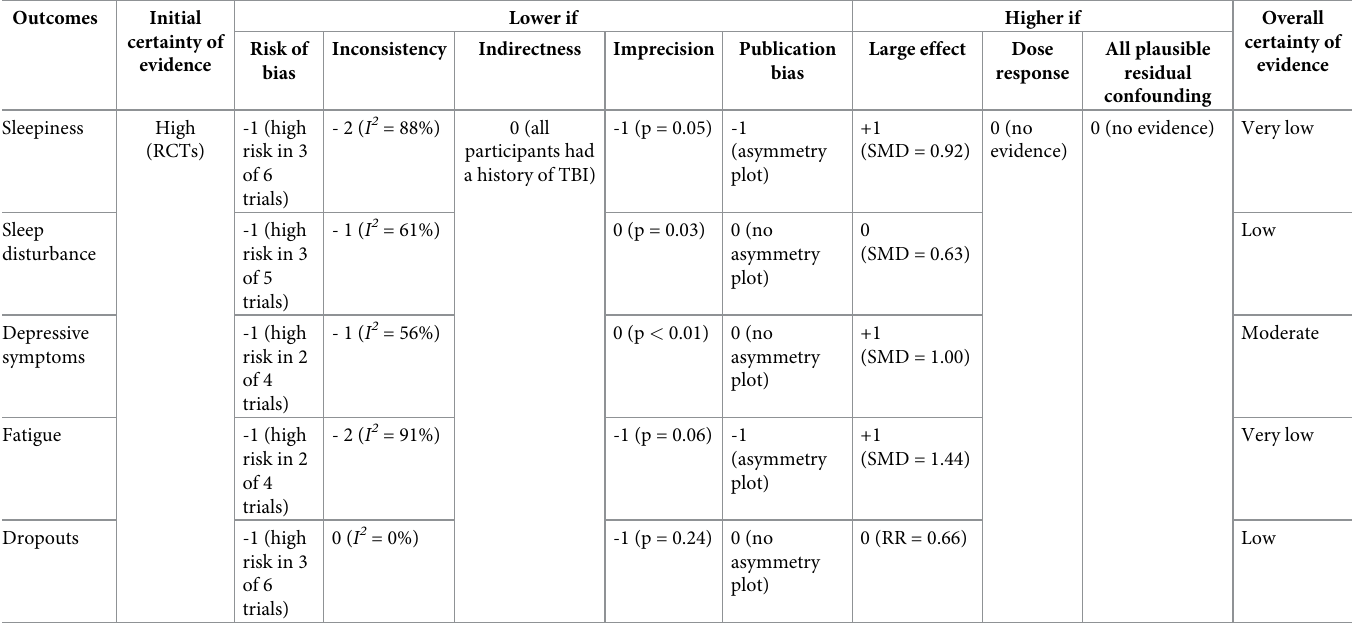
Table 3. The certainty of BLWT treatment effects for four behavioral